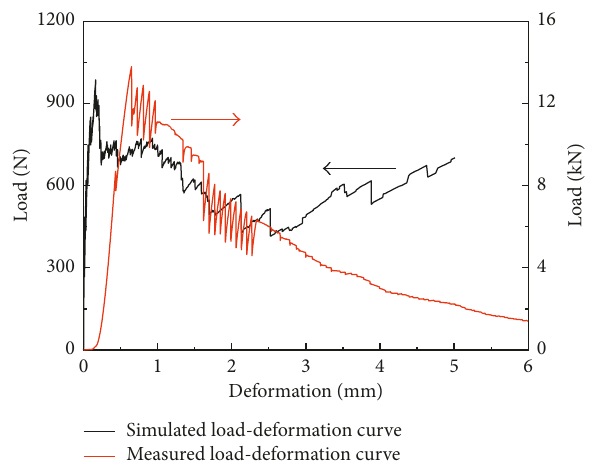
Simulated load-deformation curve Measured load-deformation curve Figure 9: Load-deformation curves of UHPFRC obtained by simulation and experiment.